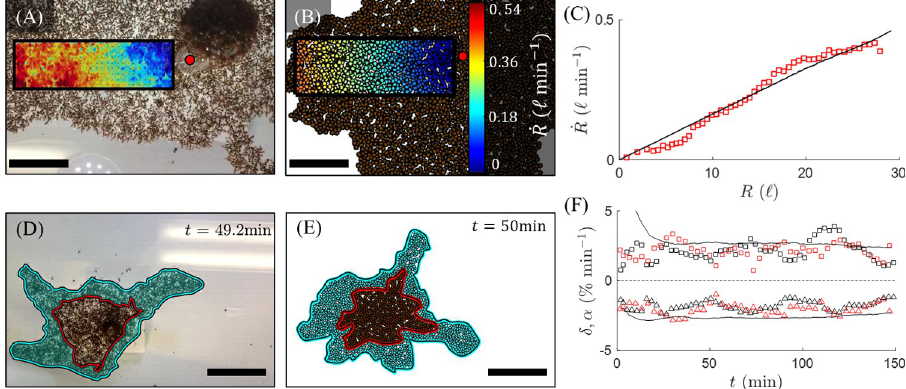
Fig 3. Comparing Treadmilling Dynamics. (A-B) The gradient of contractile speed, _ r , towards the anchor point of the rafts (red dot) is illustrated via heat maps within defined regions of interest (ROIs) for both (A) an experimental and (B) simulated raft. _ r was computed as the component of speed moving towards the stationary reference frame (i.e., the acrylic rod) and was measured for every point within these 2D ROIs, then averaged over durations exceeding 13 minutes. Scale bars represent 10 ℓ . (C) _ r is plotted with respect to distance from the anchor point, r , for both the experiment (discrete red squares) and simulation (solid black curve). The slopes of the least-squares regression lines are taken as the average contractile strain rate _ ε . The experimental strain rate ( _ ε ¼ 1 : 63 � 0 : 01 % min (cid:0) 1 ; R 2 ¼ 0 : 96 ) agrees with the numerical value ( _ ε ¼ 1 : 62 % min (cid:0) 1 ; R 2 ¼ 0 : 99 ). (D-E) The growth zones of both (D) an experimental and (E) simulated raft after roughly 50 min are shaded in cyan. Scale bars represent 15 ℓ . The bound ants that occupied the perimeter of the raft at reference time, t 0 = 0, are outlined in red and were traced through time. (F) The time- evolution of the edge binding rate, α , and bulk unbinding rate, δ , as a percentage per unit raft area are shown for two sets of experiments (squares for α and triangles for δ ; red and black for two different experiments) along with the averaged results of 12 simulations (continuous black curves). Note that the initial drops in both α and δ for the simulation data occur since the raft was not initiated at steady state, whereas experimental data was only sampled at pseudo-steady state. (A,C,D,F) Experimental results are courtesy of Wagner, et al. (2021) [14]. All simulated rafts were initiated as circles and shape was allowed to evolve